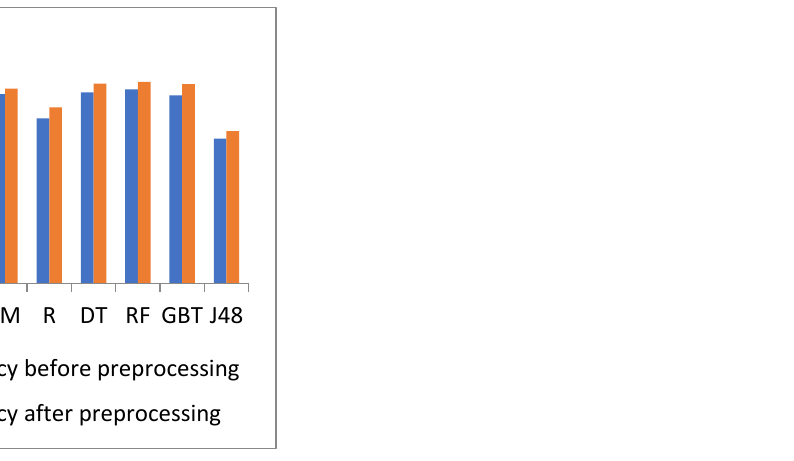
Figure 14. Accuracy comparison of different algorithms on diabetes disease before and after pre- processing.